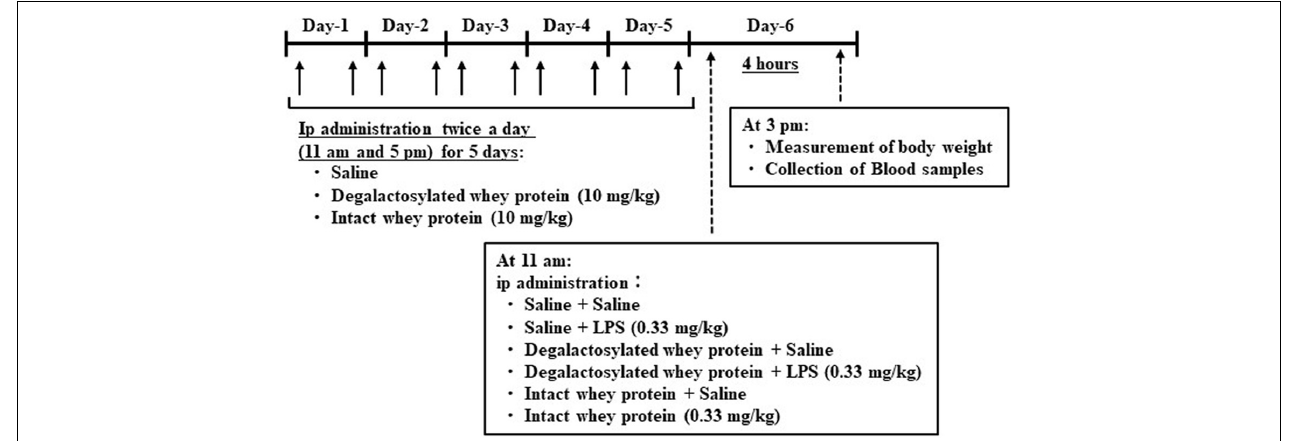
FIGURE 1 | Schematic representation of in vivo experimental schedule in